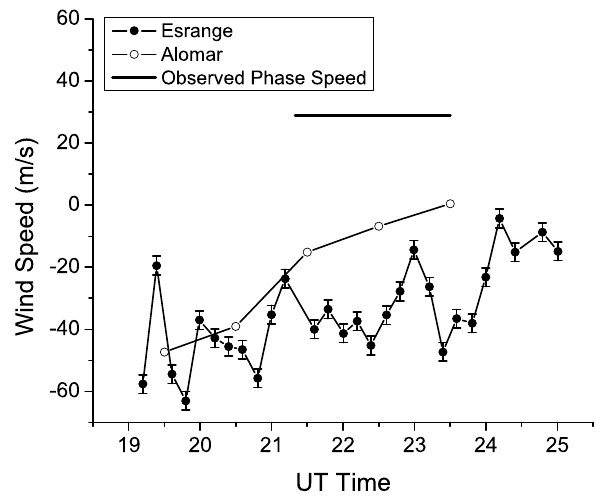
Fig. 11. Plot showing the horizontal wind field in the direction of the January 29/30 wave as a function of time. Both wind fields over Andenes and Esrange are shown. As before, the horizontal line indicates the duration of the wave and its observed phase speed. Fig. 10. This map shows the 29/30 January wave event in the Na emission mapped onto the same geographical as Fig. 4. The wave progressed overhead at Esrange with a SW heading (indicated by the arrow).